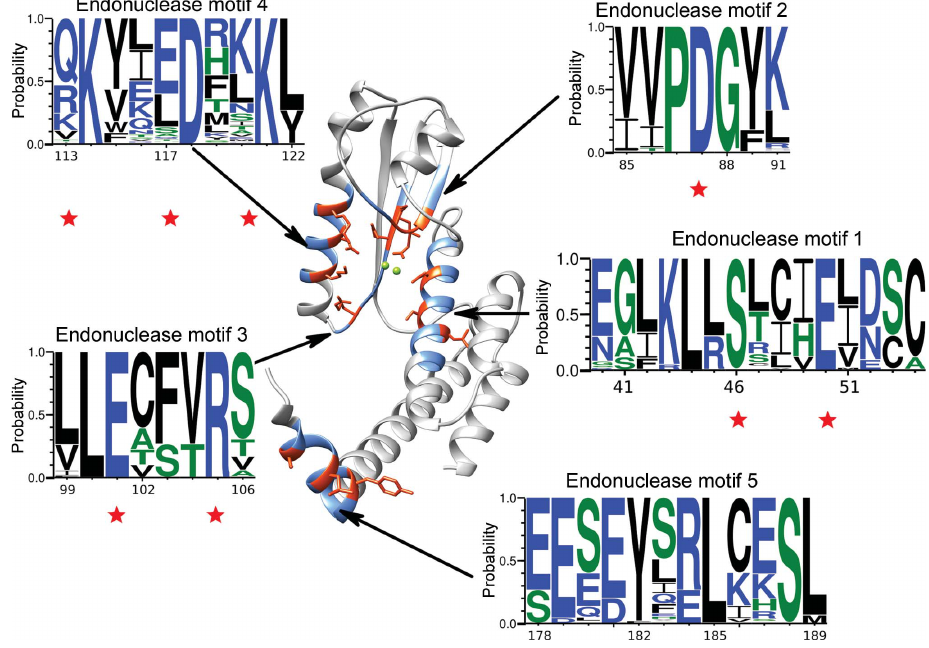
Figure 4 The five motifs (blue) that are conserved across all available sequences of the Arenaviridae endonuclease domain plotted on the LCMV structure (grey). Conserved motifs are shown in WebLogo representation. The size of the letter is representative of the frequency with which it observed in the alignment (with a probability of 1 being identity). The numbering of the residues refers to the sequence of LCMV. Motifs 1–4 represent the four positions that can be used to anchor a ligand over all Arenaviridae . Residues marked with a star correspond to key residues involved in the active site or in substrate binding, and their side chains are highlighted on the structure